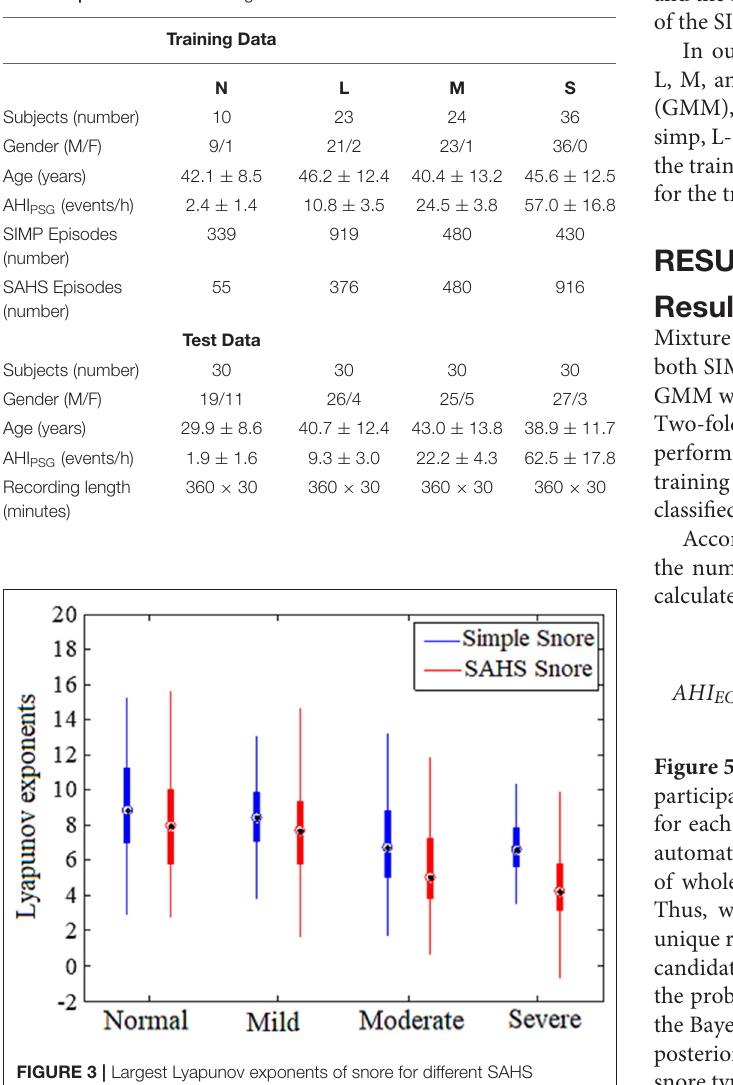
while SAHS snoring may form a certain trend of airflow after being squeezed in the narrow upper